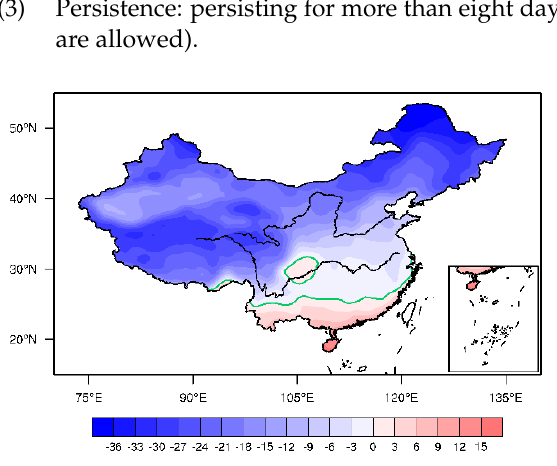
Figure 1. Spatial distribution of winter-averaged low-temperature threshold (green contour denotes the 0 value, unit: °C).